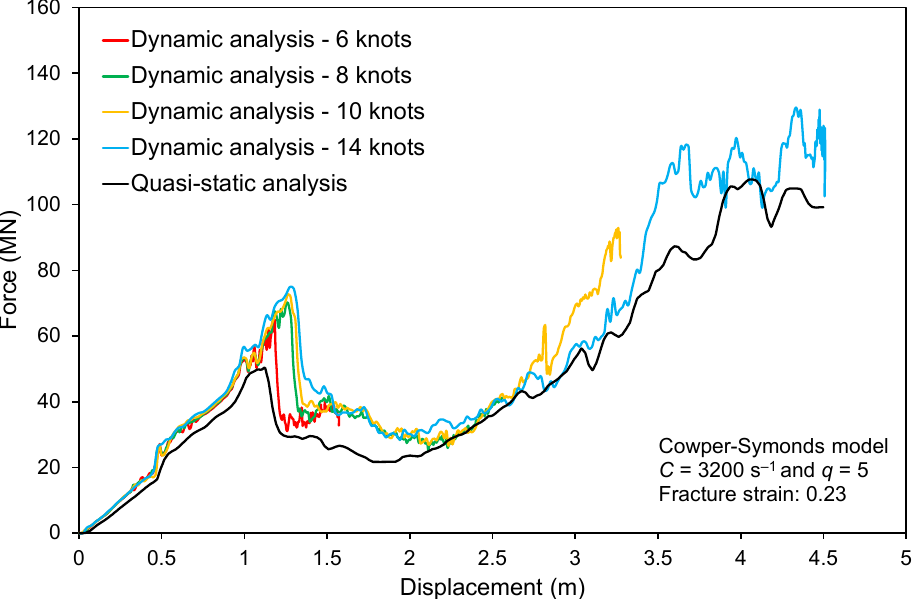
Figure 12. Force–displacement curves obtained for different speeds using the Cowper–Symonds model and comparison with quasi-static analysis results.